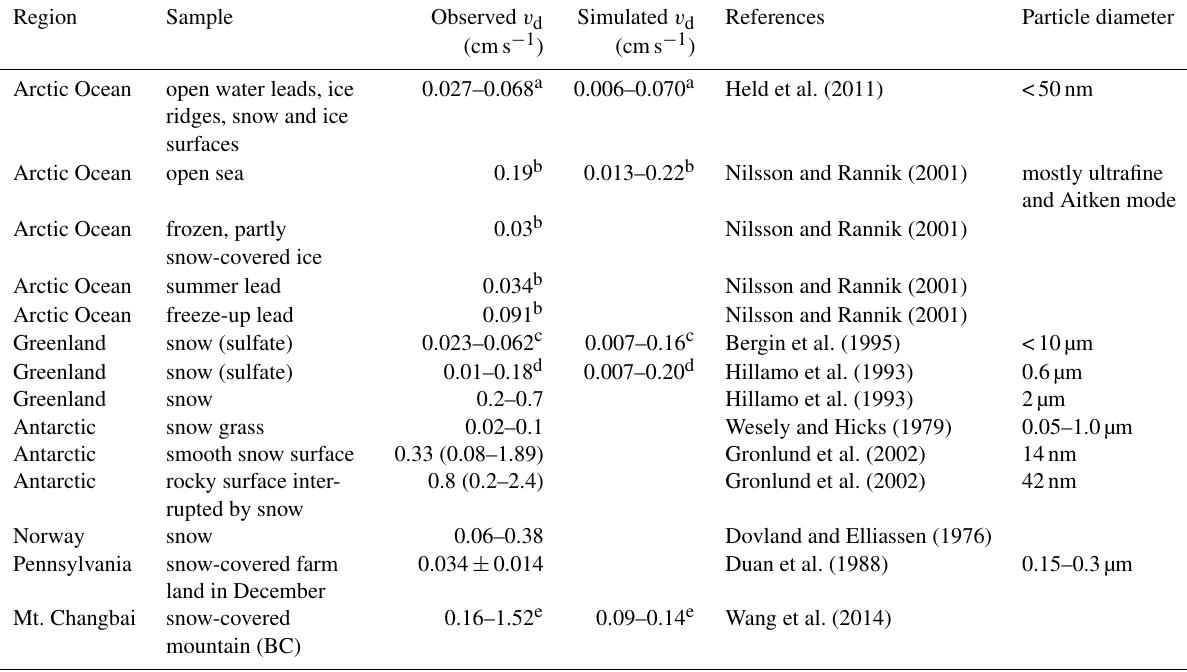
Table 3. Observed and simulated dry deposition velocity ( v d ) using resistance-in-series method over snow and